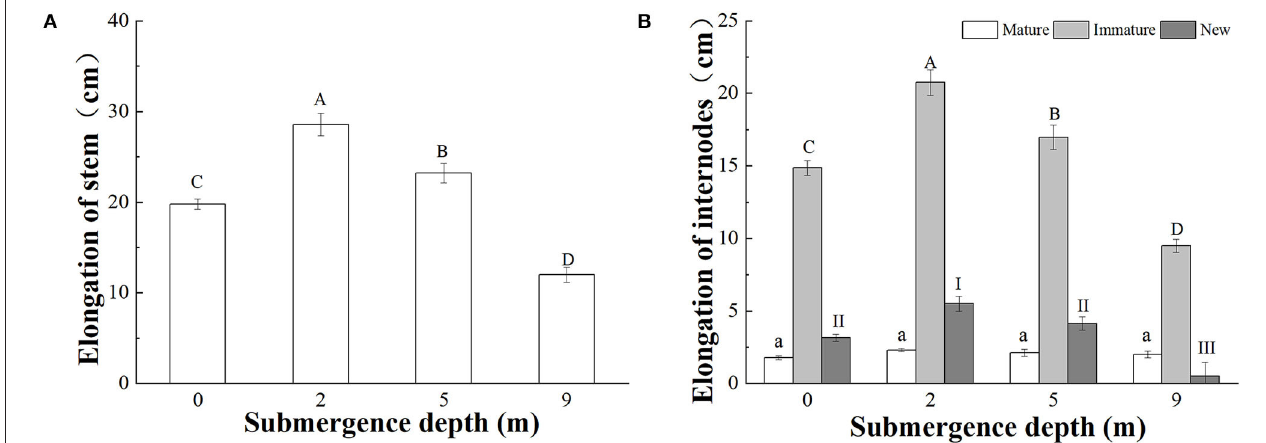
FIGURE 2 | Stem elongation of (A) the whole stem; (B) mature and immature internodes before the treatments, and new internodes produced during the treatments, of A. philoxeroides at the end of treatments at different submergence depths (mean ± S.E; n = 20). Different lower-case letters indicate a significant difference ( p < 0.05) in the elongation of mature internodes between treatments. Different upper-case letters indicate significant differences ( p < 0.05) in elongation of the whole stem (A) and immature internodes (B) between treatments. Different roman letters indicate significant differences ( p < 0.05) in the elongation of new internodes between treatments.